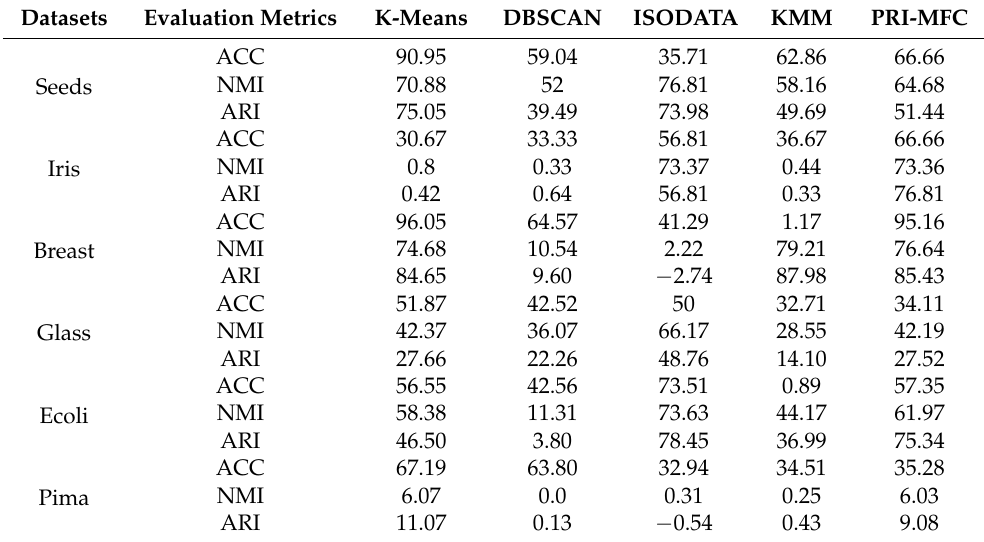
Table 4. Clustering evaluation index values of five algorithms on the UCI datasets(%).